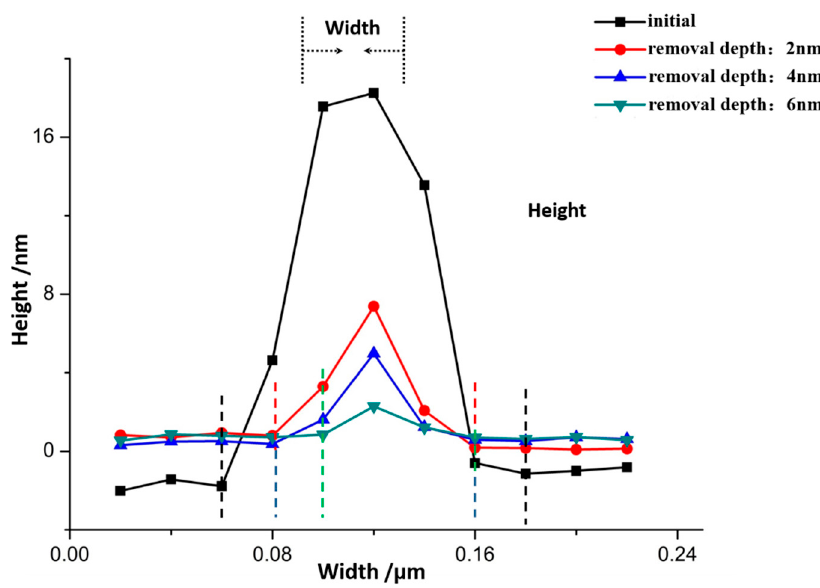
Figure 7. Size evolution of bulges in EJP preprocessing.